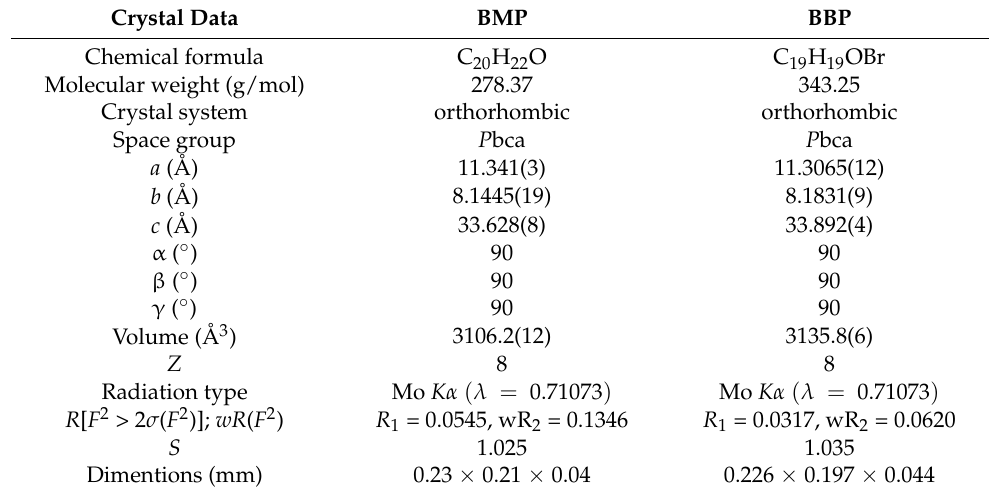
Table 1. Crystallographic data and structure refinement for BMP and